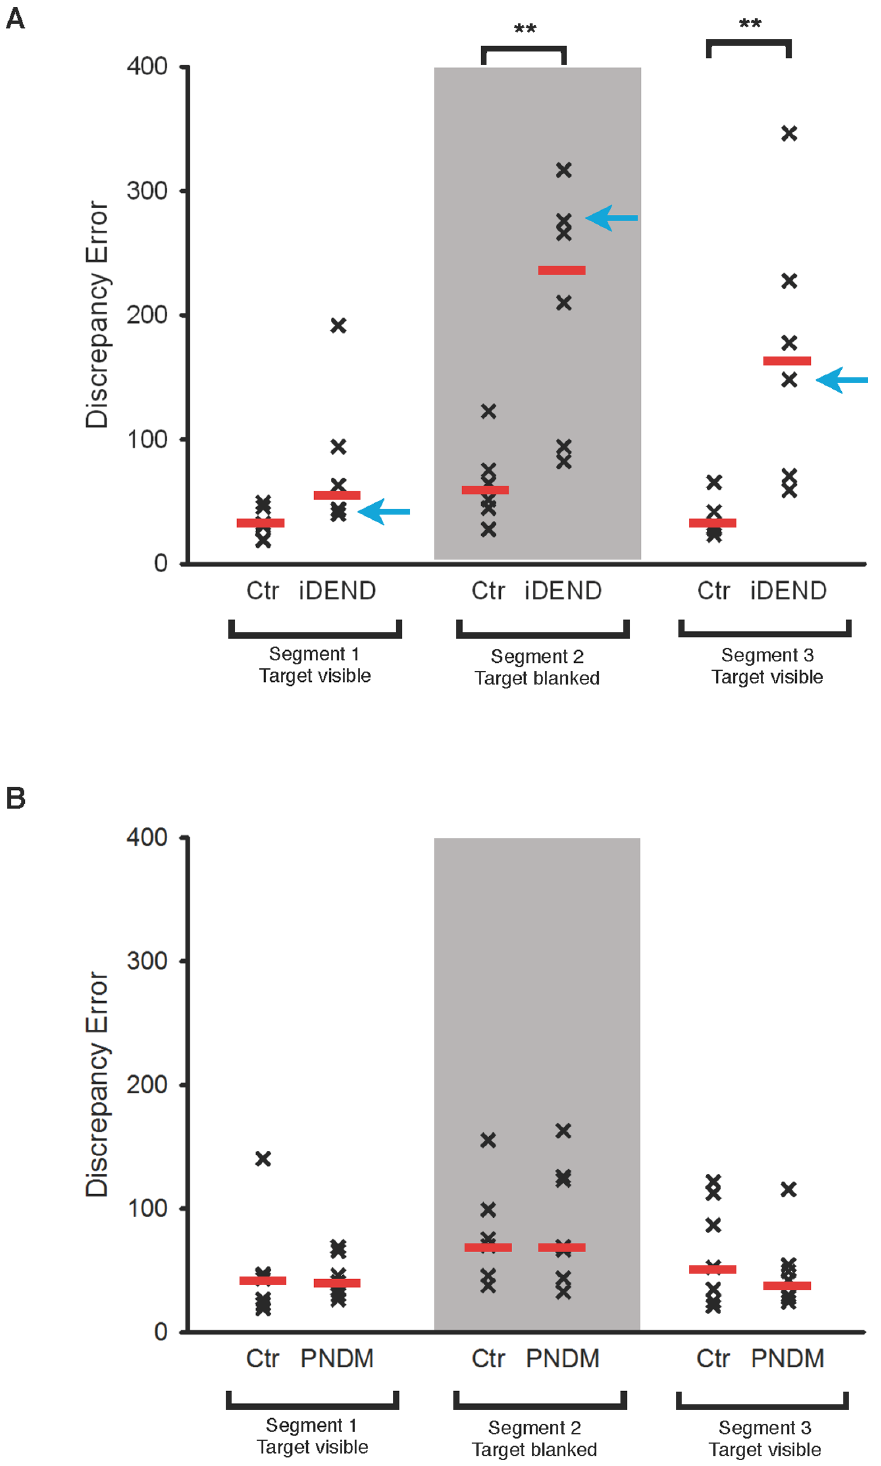
Figure 3. Comparison of visually-guided and blanked tracking performance of patients with PNDM and iDEND. Scatter plots showing discrepancy errors of iDEND patients (A, n=6) and PNDM (B, n=7) patients and their matched controls (Ctr), as indicated, on the linear tracking task with target blanking. The visually guided (first and last) and blanked (middle) segments of this task were analysed separately. Red bars indicate the median error. Discrepancy errors of iDEND patients were significantly higher than controls in segments 2 and 3. **, p , 0.01 post-hoc Mann-Whitney U-tests. There were no differences between PNDM patients and controls in any of the three segments (Kruskal-Wallis test).